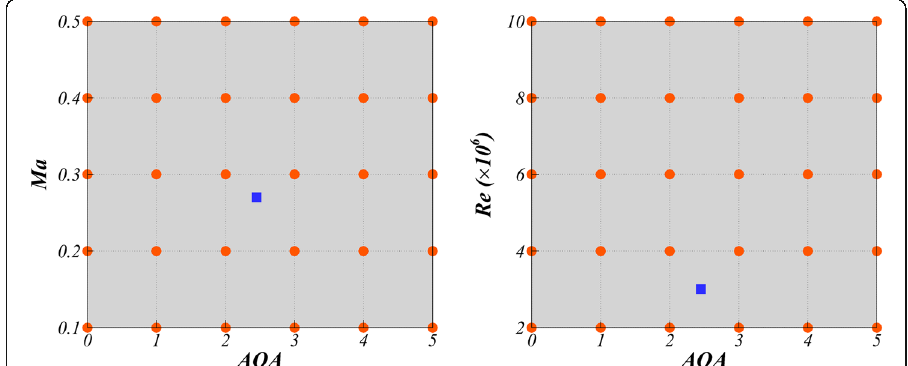
Fig. 11 Training (blue square) and test (orange circle) cases. a Re = 3 × 10 6 . b Ma =